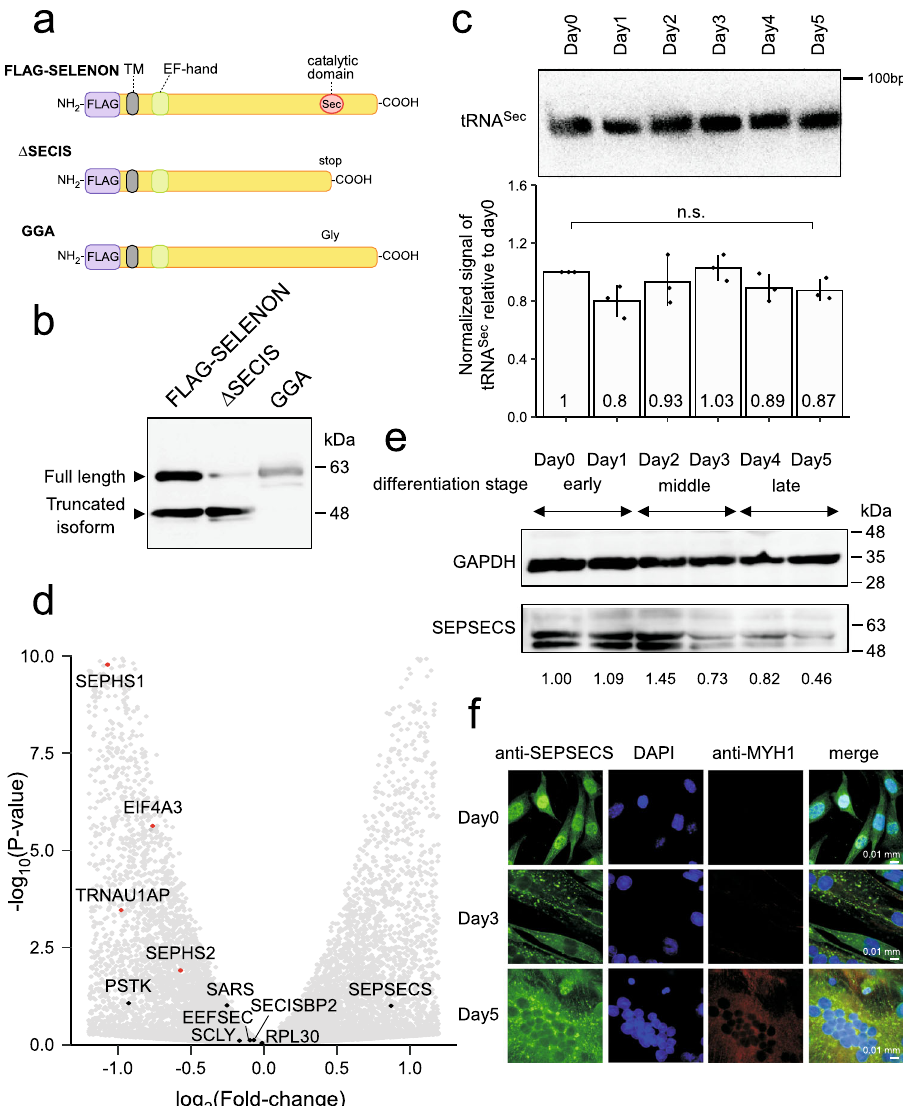
Fig. 4 Dynamic regulation of UGA/Sec recoding during myoblast differentiation. a Constructs of the FLAG-SELENON expression vector and its mutants Δ SECIS and GGA. TM (transmembrane domain), EF-hand domain, and Sec residue in the catalytic domain are indicated. b Expression of FLAG-SELENON and its mutants in HEK293T cells, detected by western blotting with an anti-FLAG antibody. This experiment was done once. c Northern blotting of cytoplasmic tRNA Sec in total RNA obtained on each day of differentiation. Relative steady-state level of tRNA Sec on each day of differentiation compared with the level on Day 0 is shown below. Results were normalized relative to the band intensity of 5.8 S rRNA in the same sample. Data are presented as mean values ±S.D. Statistical signi fi cance was determined by unpaired two-tailed t test; n = 3 biologically independent samples. d Volcano plot of RNA-seq transcriptome data showing altered gene expression [log 2 (fold-change)], with p values, on Day 5 versus Day 0 of Hu5/KD3 cell differentiation. UGA/Sec recoding factors are indicated, and signi fi cantly differentially expressed genes (two-sided p value <0.05 determined by likelihood ratio test) are highlighted in red. e Expression analyses of GAPDH (control) and SEPSECS in differentiating Hu5/KD3 cells by western blotting on the indicated days. The expression level of SEPSECS was normalized to that of GAPDH , making the relative expression level on Day 0 = 1.00 (shown below). The samples derived from the same experiment and the gels/blots were processed in parallel. This experiment was repeated more than three times independently with similar results. f Subcellular localization of SEPSECS on the indicated days in differentiating Hu5/KD3 cells immunostained with an anti-SEPSECS antibody (green). Nuclei were stained with DAPI (blue) and myotubes were stained with an anti-myosin antibody (red). Magni fi cation: ×100. Exposure time: 150 ms (Day 0) or 300 ms (Day 3 and 5). This experiment was done once. Source data and unprocessed gel image are provided in Source Data fi